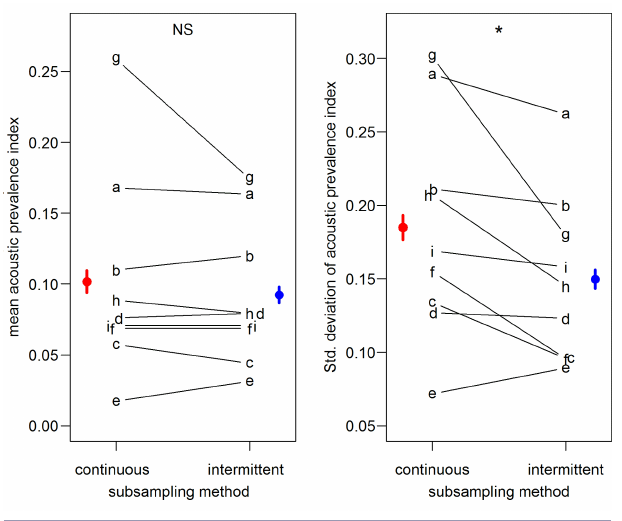
Fig. 2 . Comparison of the mean and SD of the acoustic prevalence index obtained from continuous and